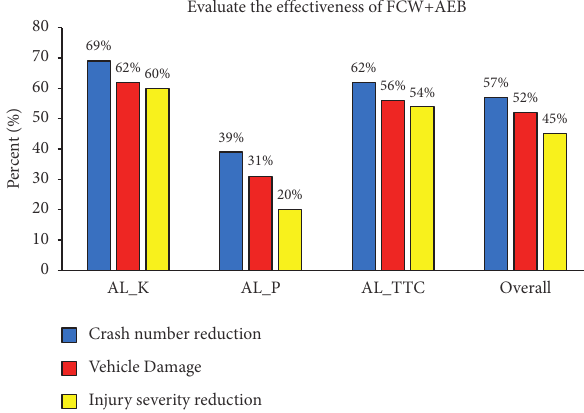
Figure 8: Summary of the estimated effectiveness of FCW +AEB in three aspects.